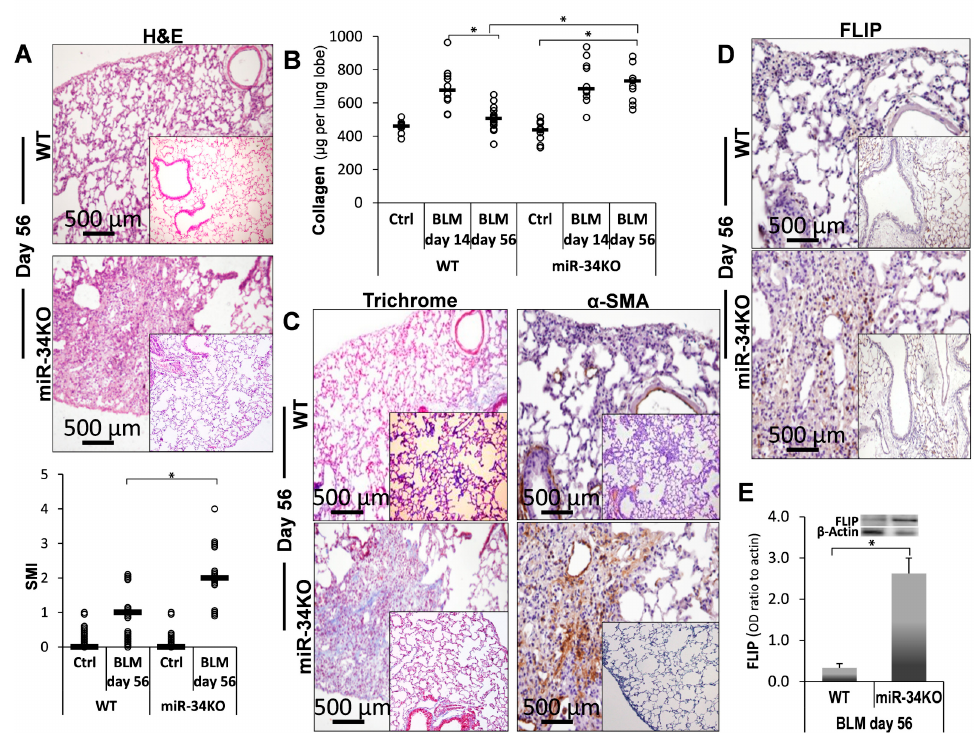
Figure 6. Persistent fibrosis in Bleomycin ‐ treated miR ‐ 34 KO as opposed to recovery in WT mice. ( A ) H&E staining (Upper panels), with graphical presentation of SMI ‐ H&E (Lower panel), at day 56 post ‐ BLM (vs. saline, inserts), in WT and miR ‐ 34 KO murine lung tissue sections. ( B ) Sircoll ‐ collagen assay at indicated days, and ( C ) Masson ‐ Trichrome (blue), with α SMA (brown). ( D ) FLIP (brown) IHC at day 56 post ‐ BLM in WT, and miR ‐ 34 KO mice lung tissue sections, with ( E ) Western blot graphical presentation of FLIP levels in WT and miR ‐ 34 KO in isolated lung fibroblasts on day ‐ 56. n = 3–4 for each time point. Representative results from three independent experiments. Error bars represent mean ± SD; circles represent individual data points. * p ≤ 0.01–0.05.